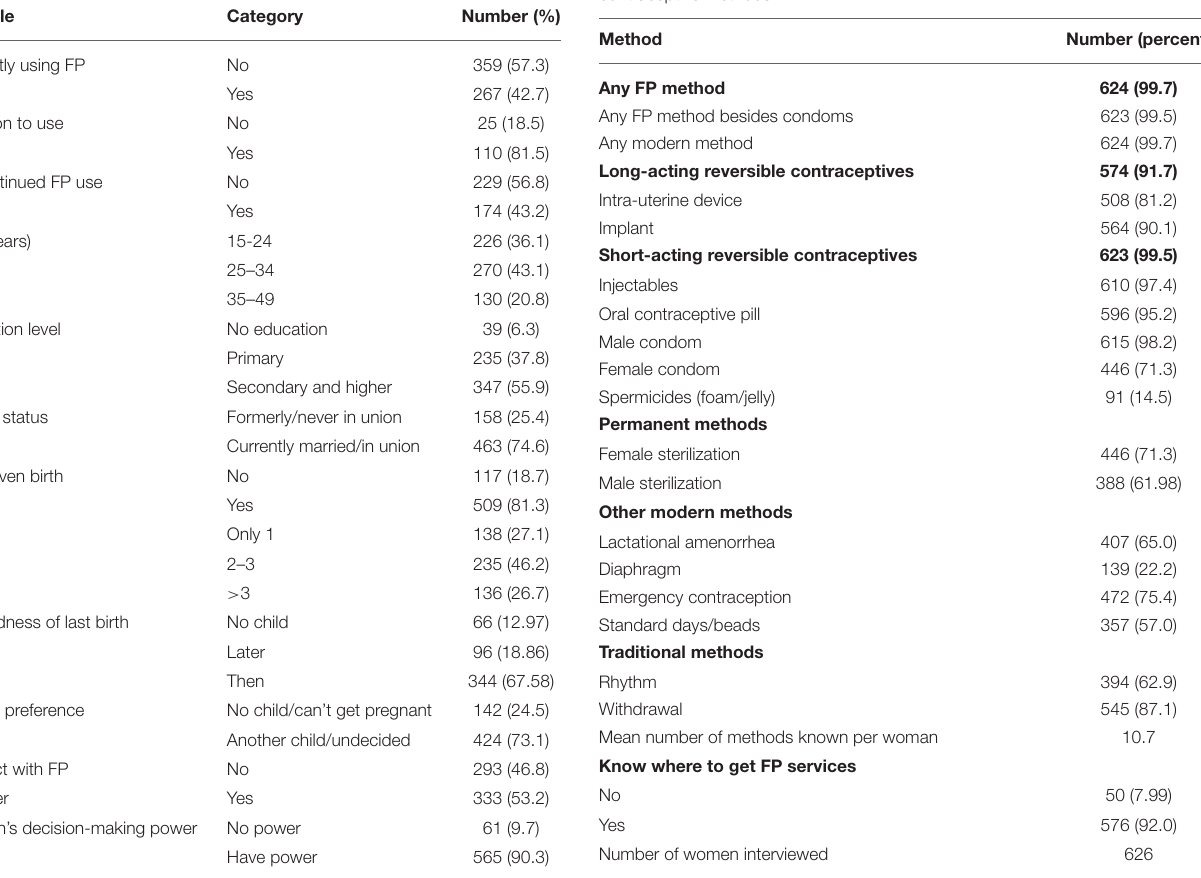
TABLE 1 | Characteristics of the study population. TABLE 2 | Knowledge of contraceptive methods and where to access contraceptive